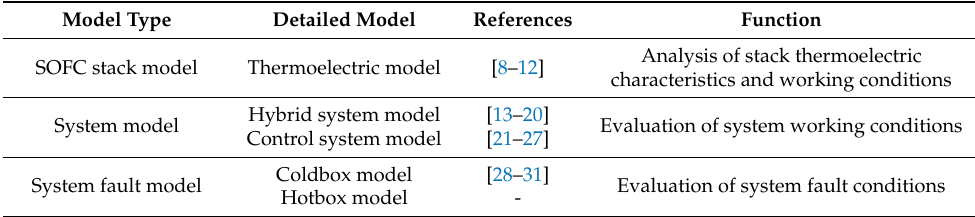
Table 1. Reference of different SOFC